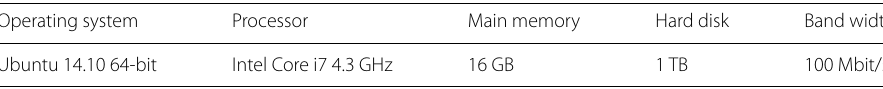
Table 2 Cluster physical machine